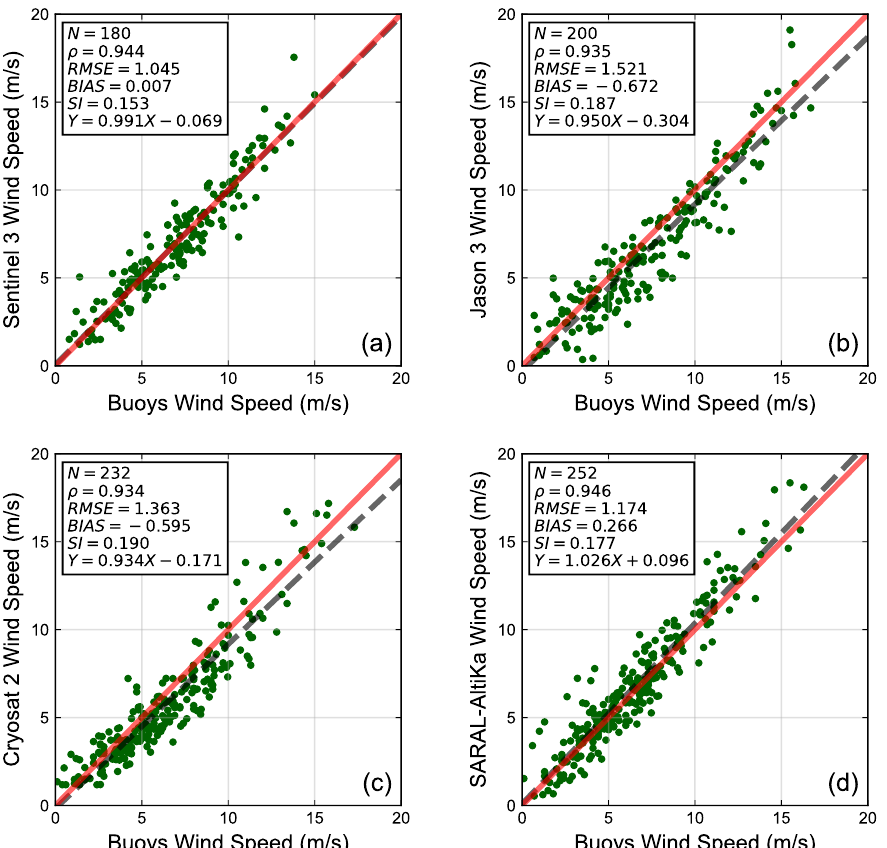
Figure 5. WS validation of ( a ) Sentinel 3, ( b ) Jason 3, ( c ) Cryosat 2 and ( d ) SARAL-AltiKa against observations from the buoys in the Northeast. N is the collocated dataset sample size and ρ is Pearson’s correlation coefficient. The dashed grey line represents the theoretical Y = X line assuming the two types of measurements are identical. The red line represents the OLS linear regression fit using X and Y to represent the collocated buoy and altimeter